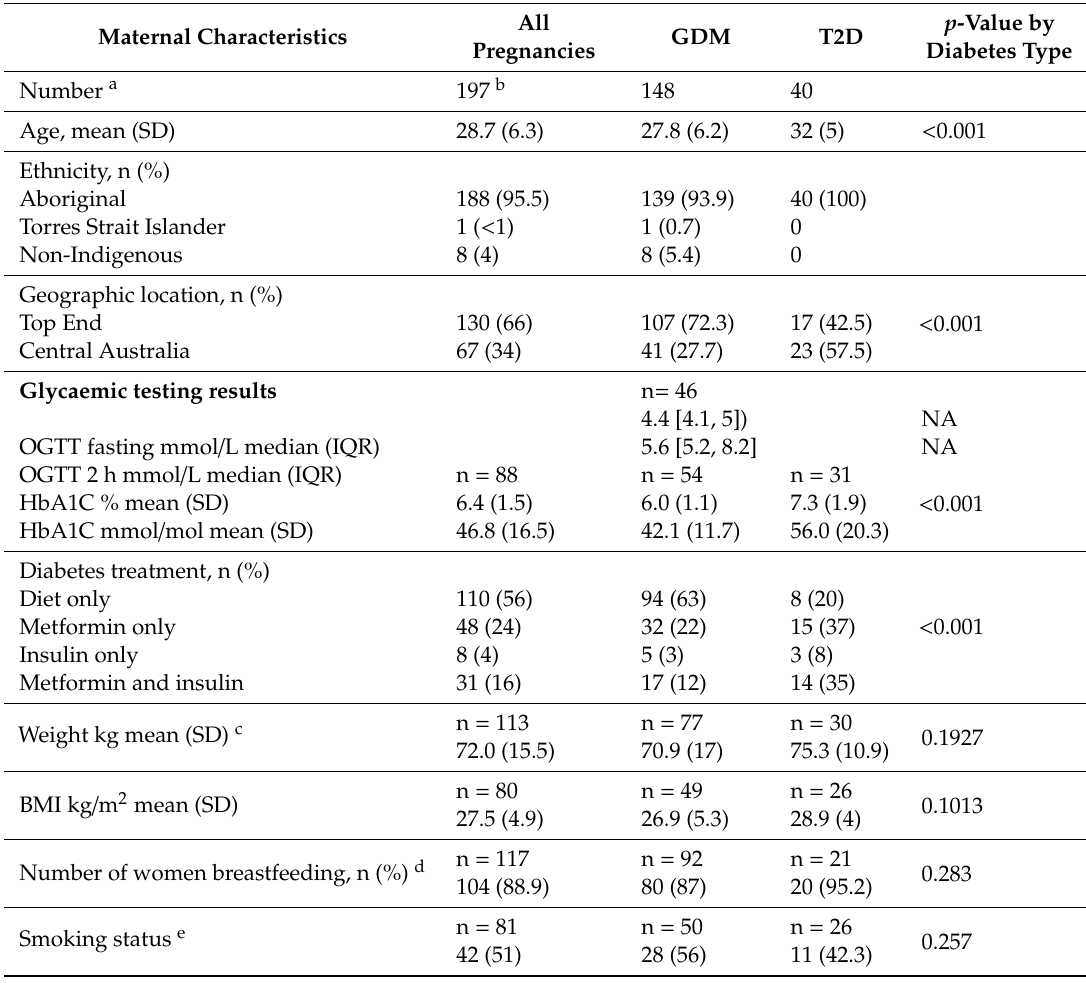
Table 1. Characteristics of women following hyperglycaemia in pregnancy and their postpartum results at any time point in the 12 month postpartum period in the Northern Territory,